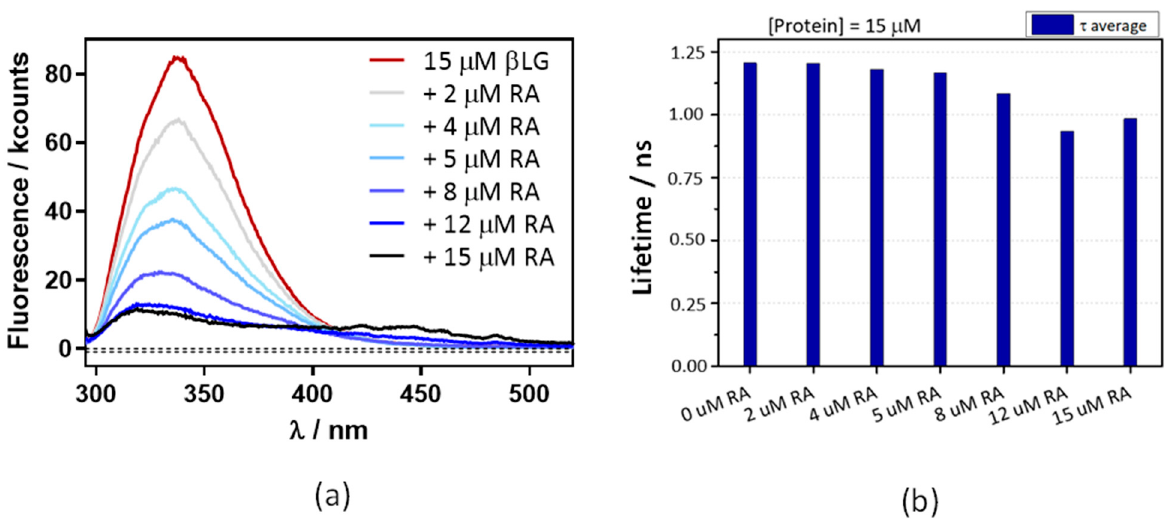
Figure 6. A decrease in β LG fluorescence lifetime ( a ) and intensity ( b ) with increasing concentrations of RA. β LG concentration was fixed at 15 µ M, excitation at 280 nm, and detection at 340 nm. The fluorescence showed multiexponential decay, thus the amplitude-averaged decay lifetime is plotted.